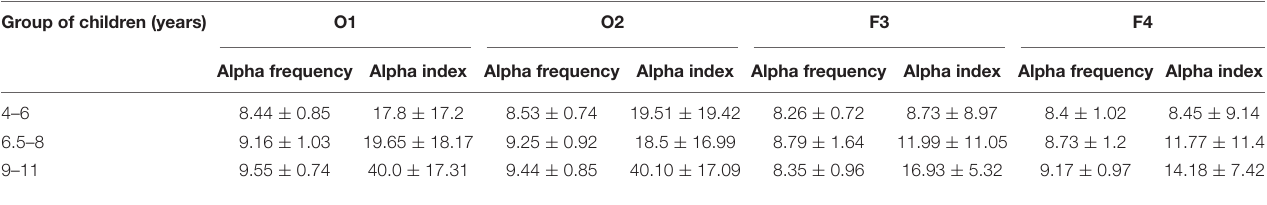
TABLE 5 | The alpha frequency and alpha index values in children of three age groups: 4–6, 6.5–8, and 9–11 years. Group of children (years)